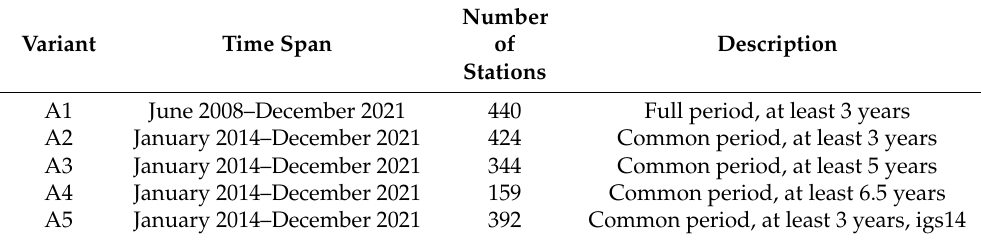
Table 2. List of analyzed time